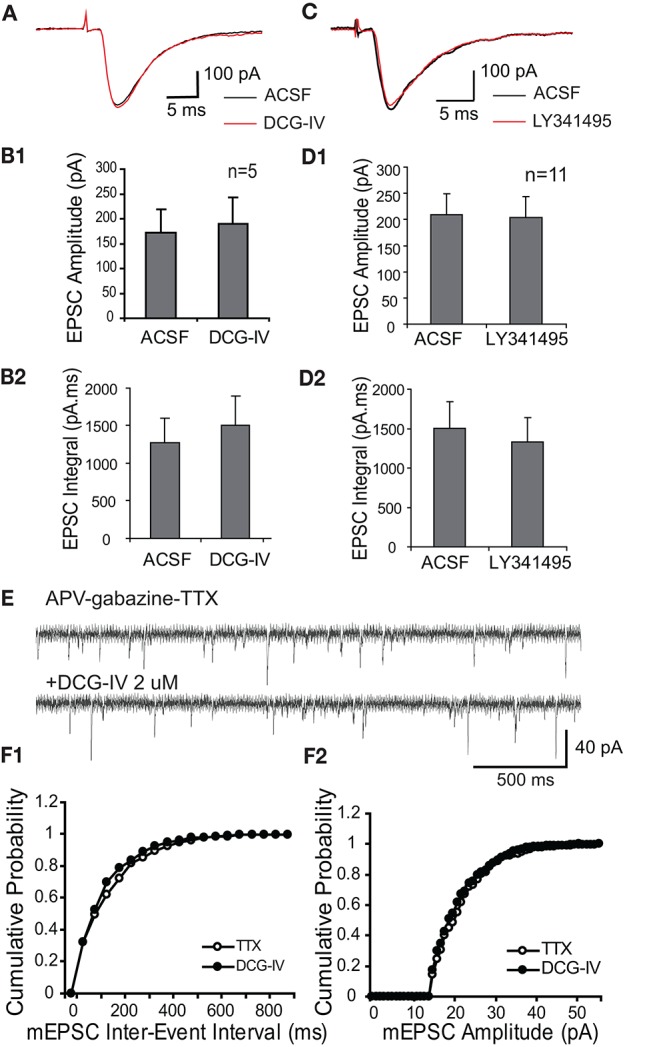
Group II mGluRs do not modulate ON-evoked or spontaneous EPSCs in ET cells. (A) The ON-evoked monosynaptic EPSC in an example ET cell (Vhold = −60 mV) is not altered by DCG-IV (2 μM); evoked responses in this and subsequent figures are averages of 10 traces unless otherwise noted. (B) Group data (n = 5) show that DCG-IV does not alter ON-evoked EPSC amplitude (B1) or integral (B2). (C) As in (A), the ON-evoked EPSC in an ET cell is not influenced by LY341495 (2 μM). (D1,2) Group data (n = 11) as in (B) for LY341495 experiments. (E) mEPSCS recorded from an ET cell (Vhold = −60 mV) in the presence of APV-gabazine-TTX were not affected by DCG-IV (2 μM). (F1,2) Cumulative inter-event (F1) and amplitude (F2) probability histograms show that DCG-IV did not affect mEPSC frequency or amplitude.